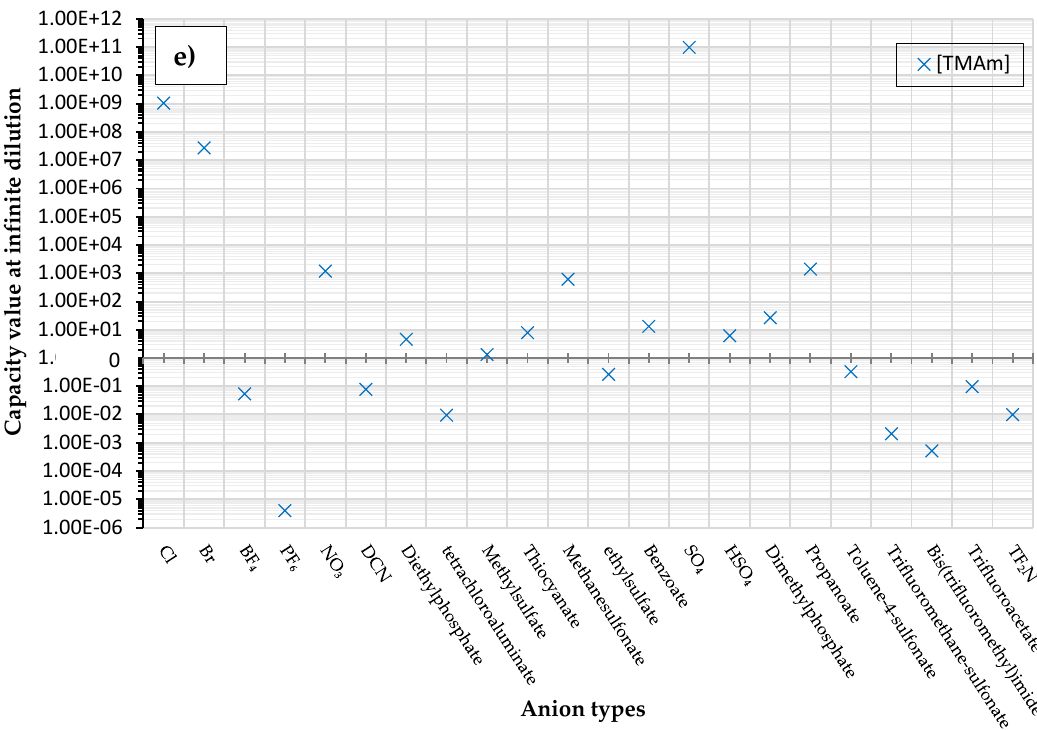
Figure 4. The capacity values at infinite dilution of ( a ) Imidazolium, ( b ) pyridinium, ( c ) Pyrrololidinium, ( d ) piperidinium, and ( e ) tetra-methyl ammonium cations alkyl chain length with 22 anion types for EPA extraction at T = 298.15 K.